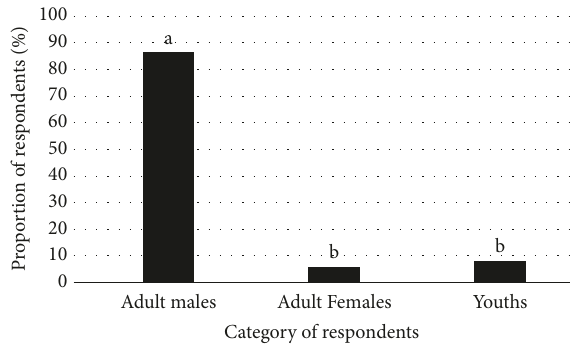
Figure 1: Proportional distribution of beekeepers in Kayonza District, Rwanda. a , b Values with different suffices were significantly different since p < .05.